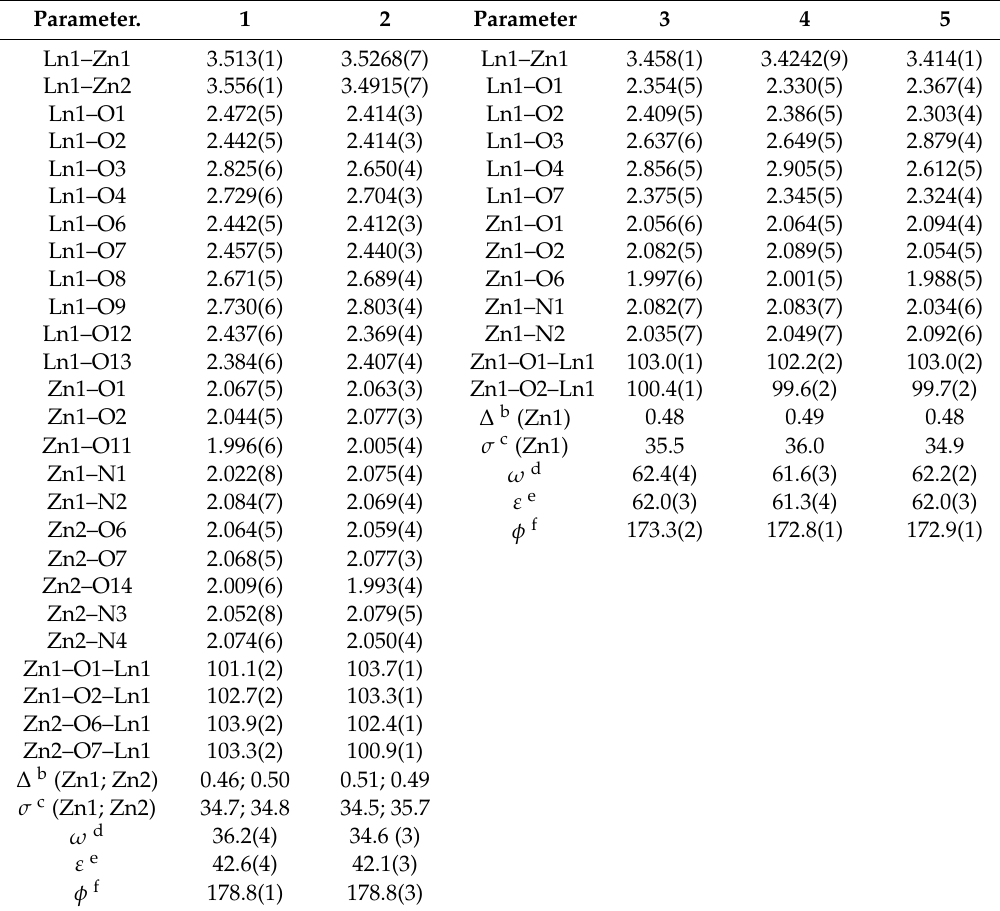
Table 1. Selected structural parameters a for complexes 1 – 5 .